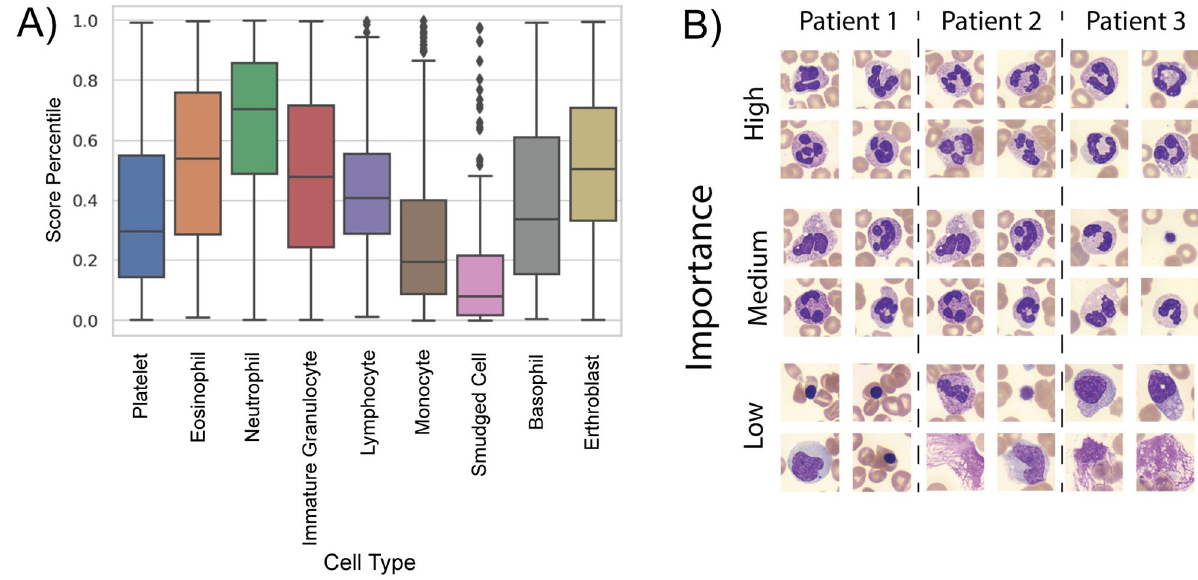
Fig 4. Cell importance analysis. A) Box plots of cell importance by detected white blood cell type. A higher score indicates higher importance. Neutrophils are the most consistently important cell type, whereas monocytes, smudged cells, and platelets are less important. The remaining cell types are moderately important and similar to each other. B) Examples of white blood cell images from three randomly sampled patients, split by importance level. Highly important cells are the cells of the patient with the highest score, medium importance cells were drawn from cells with scores closest to the 50th percentile of scores, and low importance cells were the four cells from each patient with the lowest